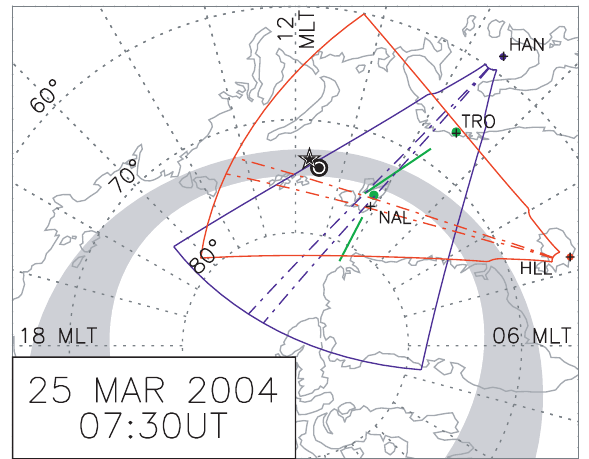
Fig. 2. A magnetic local time/magnetic latitude projection of the Northern Hemisphere at 07:30 UT on 25 March 2004. Concentric circles indicate parallels of constant magnetic latitude at 80 ◦ , 70 ◦ and 60 ◦ magnetic latitude. The radial lines indicate hours of mag- netic local time with noon located at the top of the figure. The sta- tistical location of the auroral oval for appropriate magnetic activity is also indicated (after Feldstein and Starkov, 1967).The fields-of- view of the CUTLASS pair of SuperDARN radars are superim- posed; the CUTLASS Finland radar in blue and the CUTLASS Iceland radar in red. Within these fields-of-view, the high time resolution beams beams employed in this study are indicated by dot-dashed lines. The poleward-looking low elevation beam of the ESR (between 150–500km altitude) and the beam of the EISCAT Tromsø VHF radar (between 150–650km altitude) are indicated by the solid green lines. Also shown are the magnetic footpoints of the TC1 and C1 spacecraft spacecraft (star-shaped and circular symbols, respectively) derived using the T96 magnetic field model parameterised appropriately for upstream solar wind conditions at 07:30